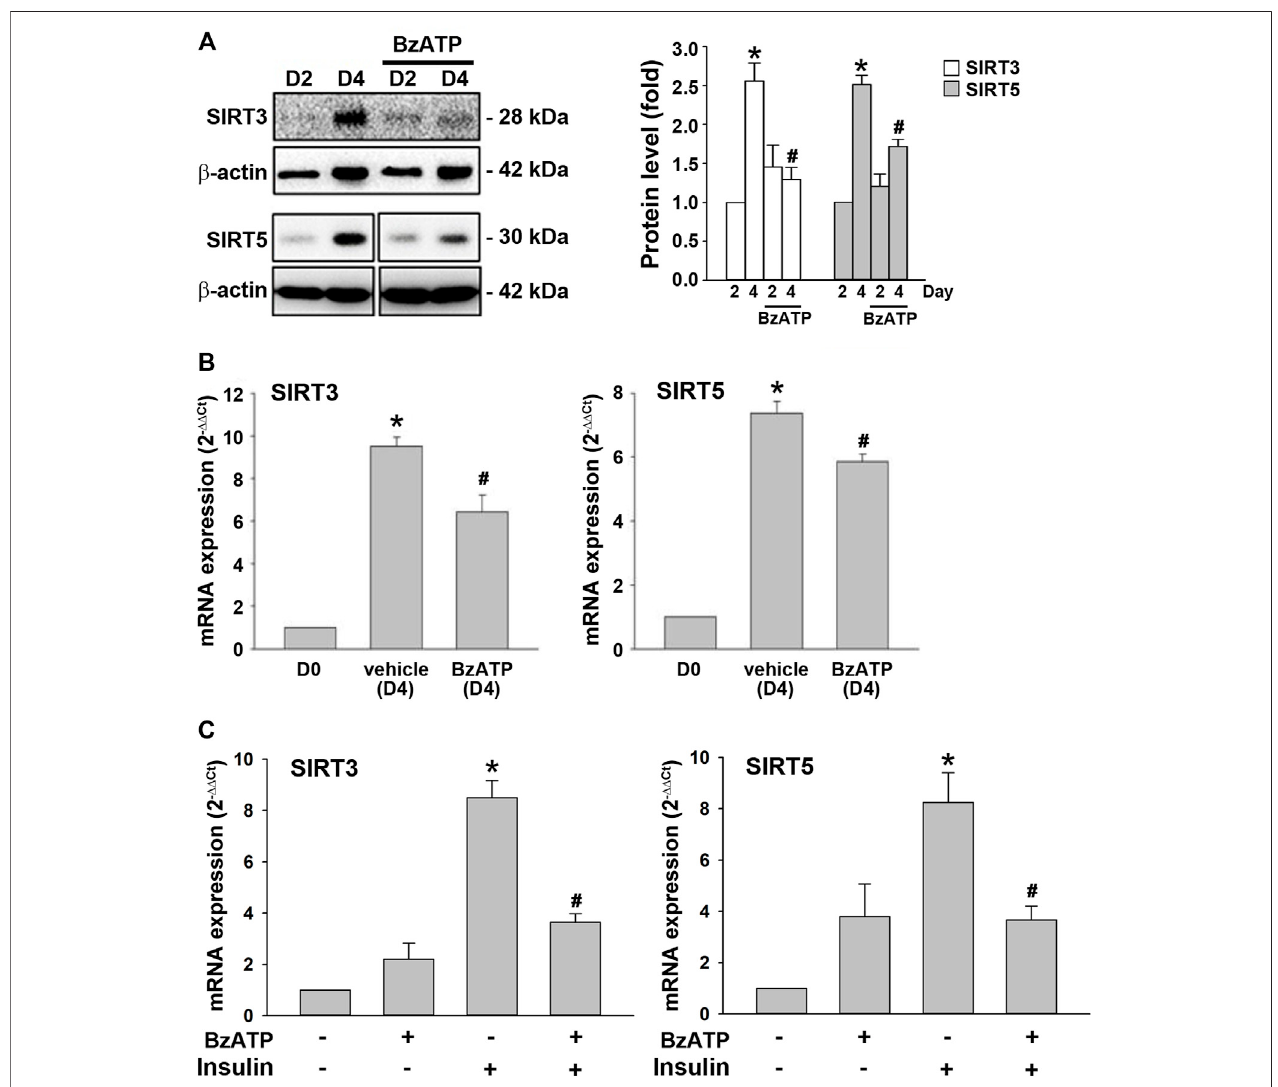
FIGURE 6 | P2X7 activation downregulates the expression of SIRT3/5 genes during adipocyte differentiation. (A,B) Cells were treated with BzATP (50 μ M) at D0 andagainattheendofD2upontherenewalofthedifferentiationmedia. (A) TheproteinlevelsofSIRT3andSIRT5atD2andD4weredeterminedbywesternblotanalysis with quanti fi cation by normalizing to β -actin. * p < 0.05 vs . differentiated adipocytes at D2. # p < 0.05 vs . vehicle-treated adipocytes at D4. (B) The mRNA levels of SIRT3 and SIRT5 at D4 were determined by qPCR. * p < 0.05 vs . preadipocytes (D0) and # p < 0.05 vs . vehicle-treated adipocytes at D4. (C) Cells after two-day differentiation (attheend ofD2)weretreatedwithBzATP (50 μ M) for24 h (determined at theend ofD3)inthepresence or absenceofinsulin (1 μ g/ml). ThemRNAlevels of SIRT3 and SIRT5 at D3 weredetermined byqPCR. * p < 0.05 vs . vehicle-treated adipocytes (D3) and # p < 0.05 vs . adipocytes treated withinsulin(D3). All quantitative data are presented as mean ± SEM from at least three independent